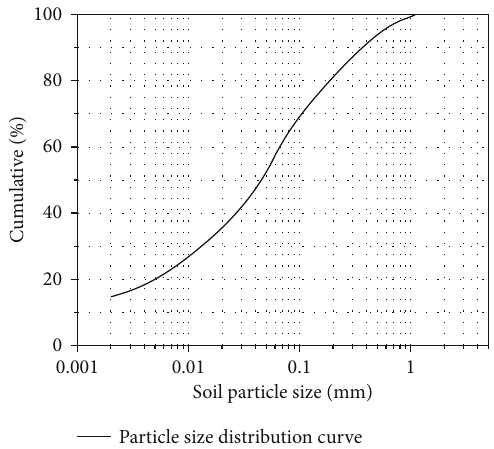
Figure 1: Particle gradation curve of the soil used in the